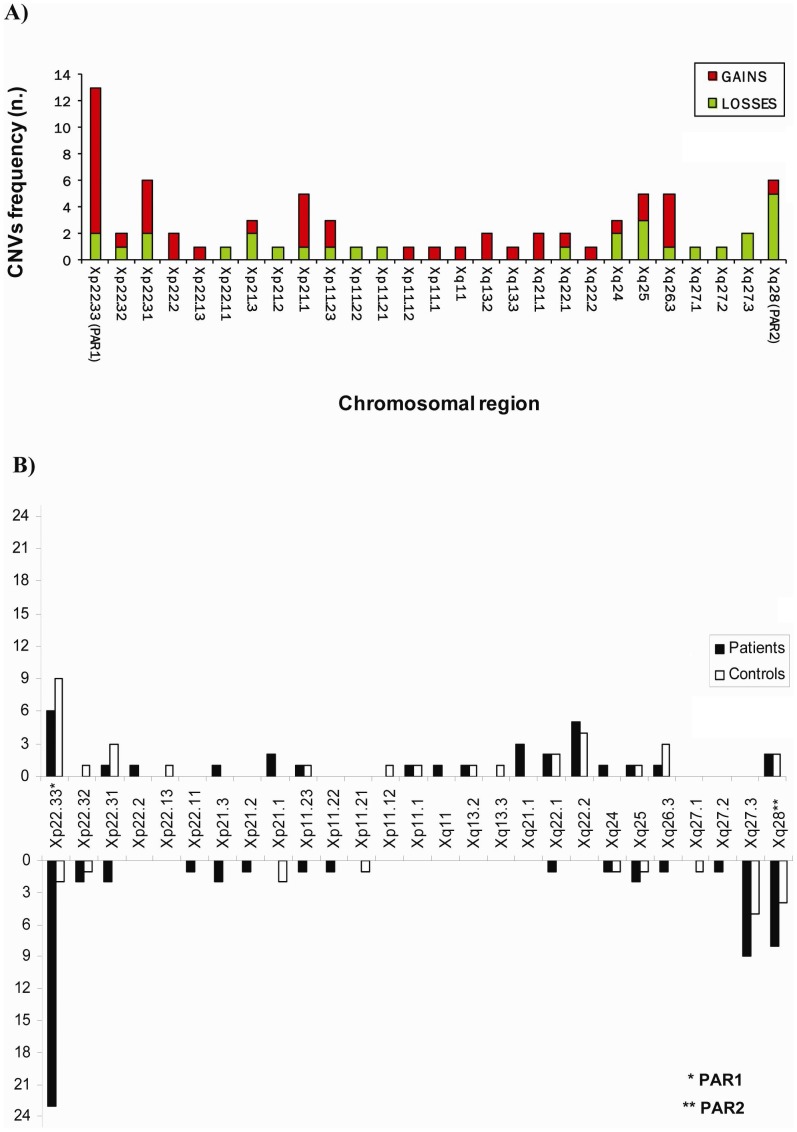
Schematic representation of the distribution of the 73 CNVs (44 gains and 29 losses) along the X chromosome identified by high resolution X chromosome specific array-CGH analysis.A) The histogram shows that the 73 CNVs were evenly distributed along the X chromosome but displayed a higher density in the pseudoautosomal region 1, PAR1 (Xp22.33). B) The frequency of gains (upwards) and losses (downwards) per X chromosome region in patients and controls are indicated.